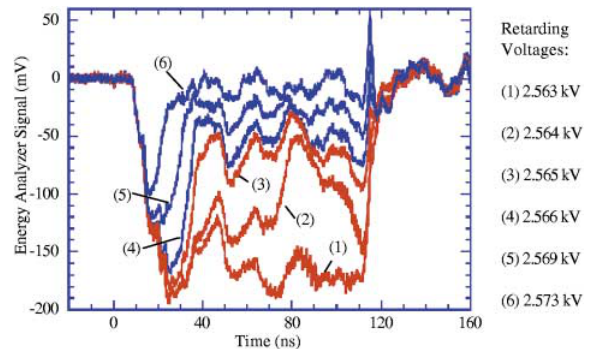
FIG. 9. (Color) Energy analyzer outputs at different retarding voltages.